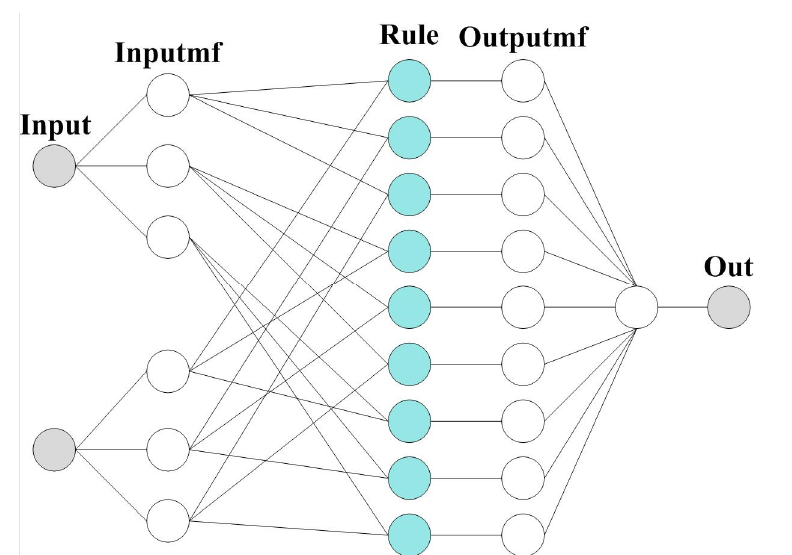
Figure 28. AN-FIS MPPT Scheme.